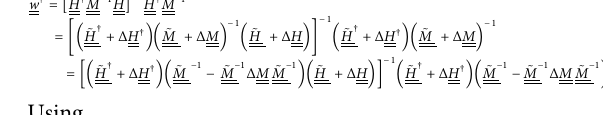
(cf. Eq. 33 ), the error 2 propagation of Capon ’ s estimator again equals the error propagation of the least square fi t estimator [15].